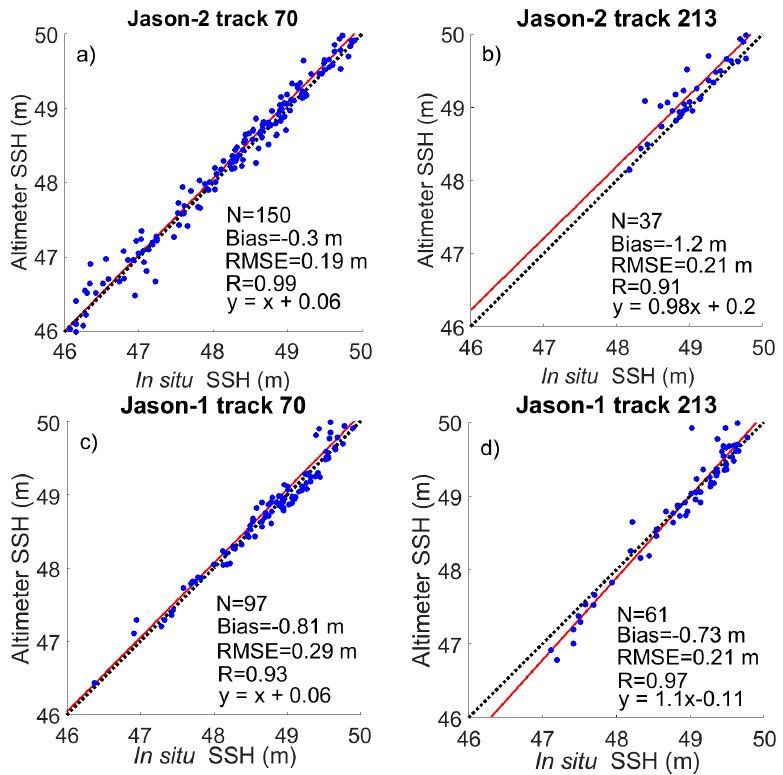
Figure 3. Comparisons between in situ and altimeter-based sea level anomalies in La Rochelle for ( a , b ) Jason-2 and ( c , d ) Jason-1 for descending track 70 and ascending track 213. The ionosphere and wet troposphere corrections were derived from GIM and ECMWF models, respectively.